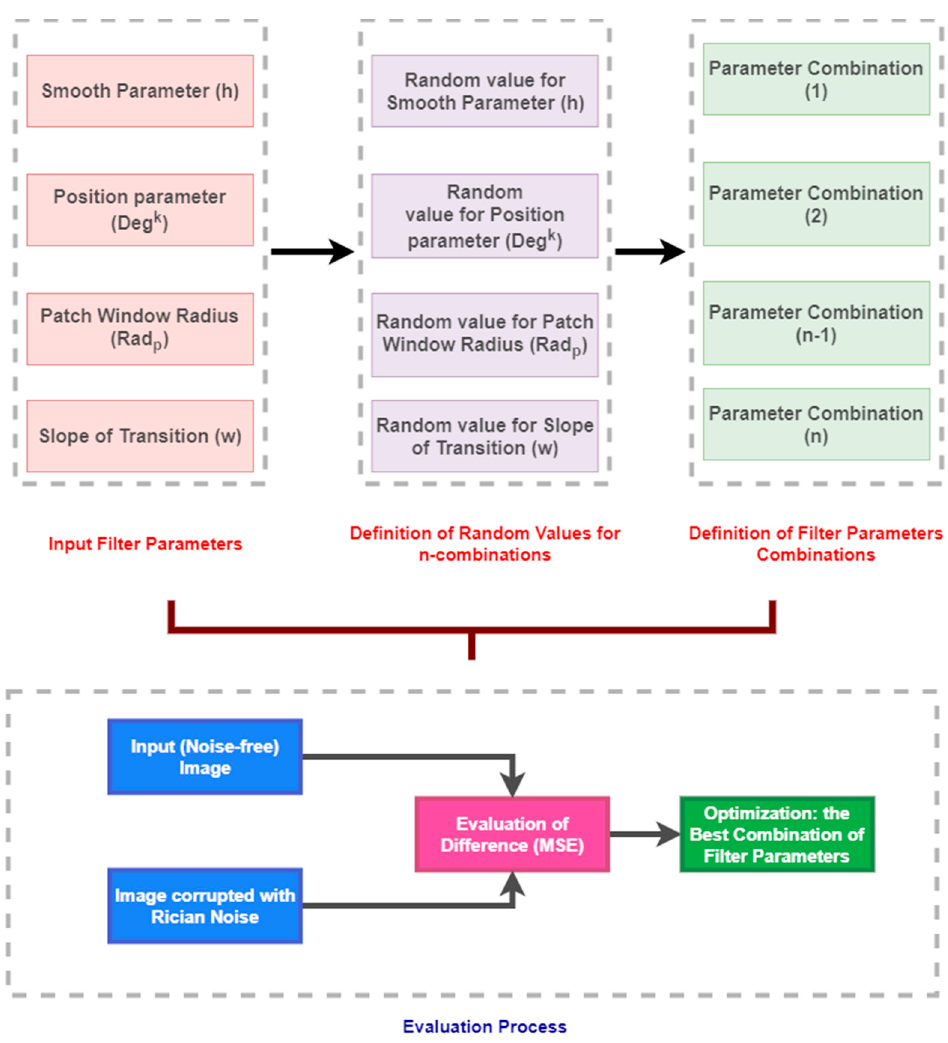
Figure 4. A proposed scheme for the filter parameters optimization bases on the random selection and MSE evaluation.